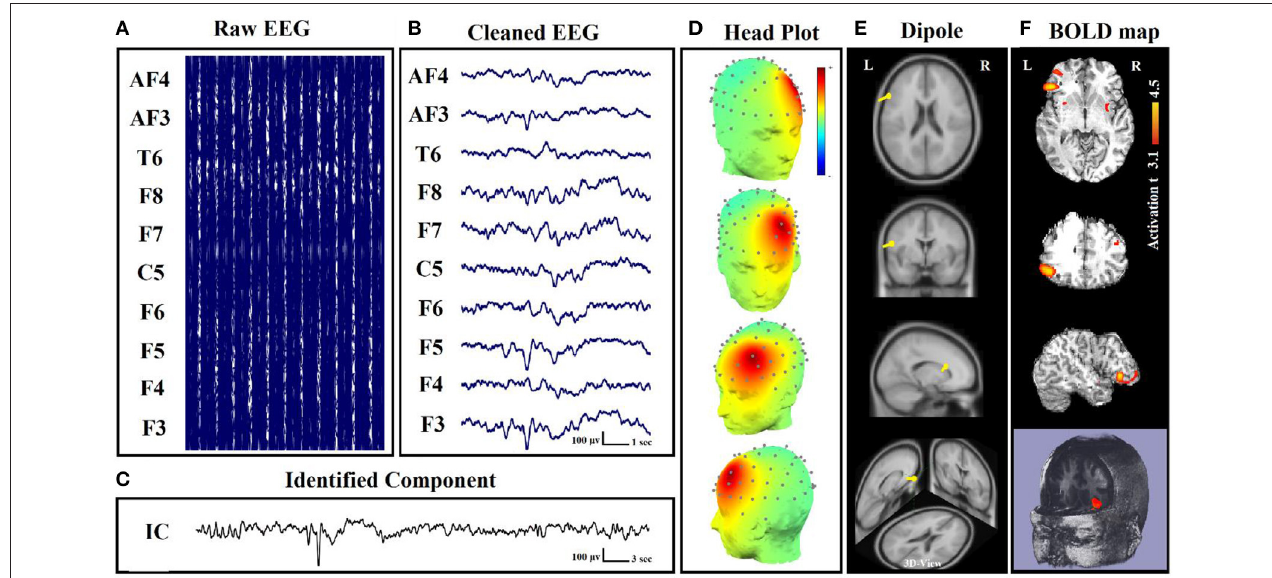
FIGURE 5 | Dipole-related BOLD response showed a focal activation in the left frontal lobe. (A) Raw EEG data acquired inside the MR scanner. (B) Cleaned EEG after removing the gradient artifact. (C) Identified component time series. (D) The component identified on scalp EEG located in the left lateral frontal lobe. The active area is marked by yellow-red color. (E) Dipole localization of the identified generator in deep brain structures. (F) Localization of the generator applying simultaneous analysis of EEG–fMRI (